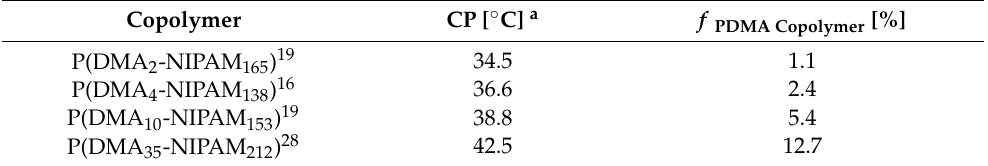
Table 3. Cloud points of P(DMA- co -NIPAM) random copolymers as obtained via visual